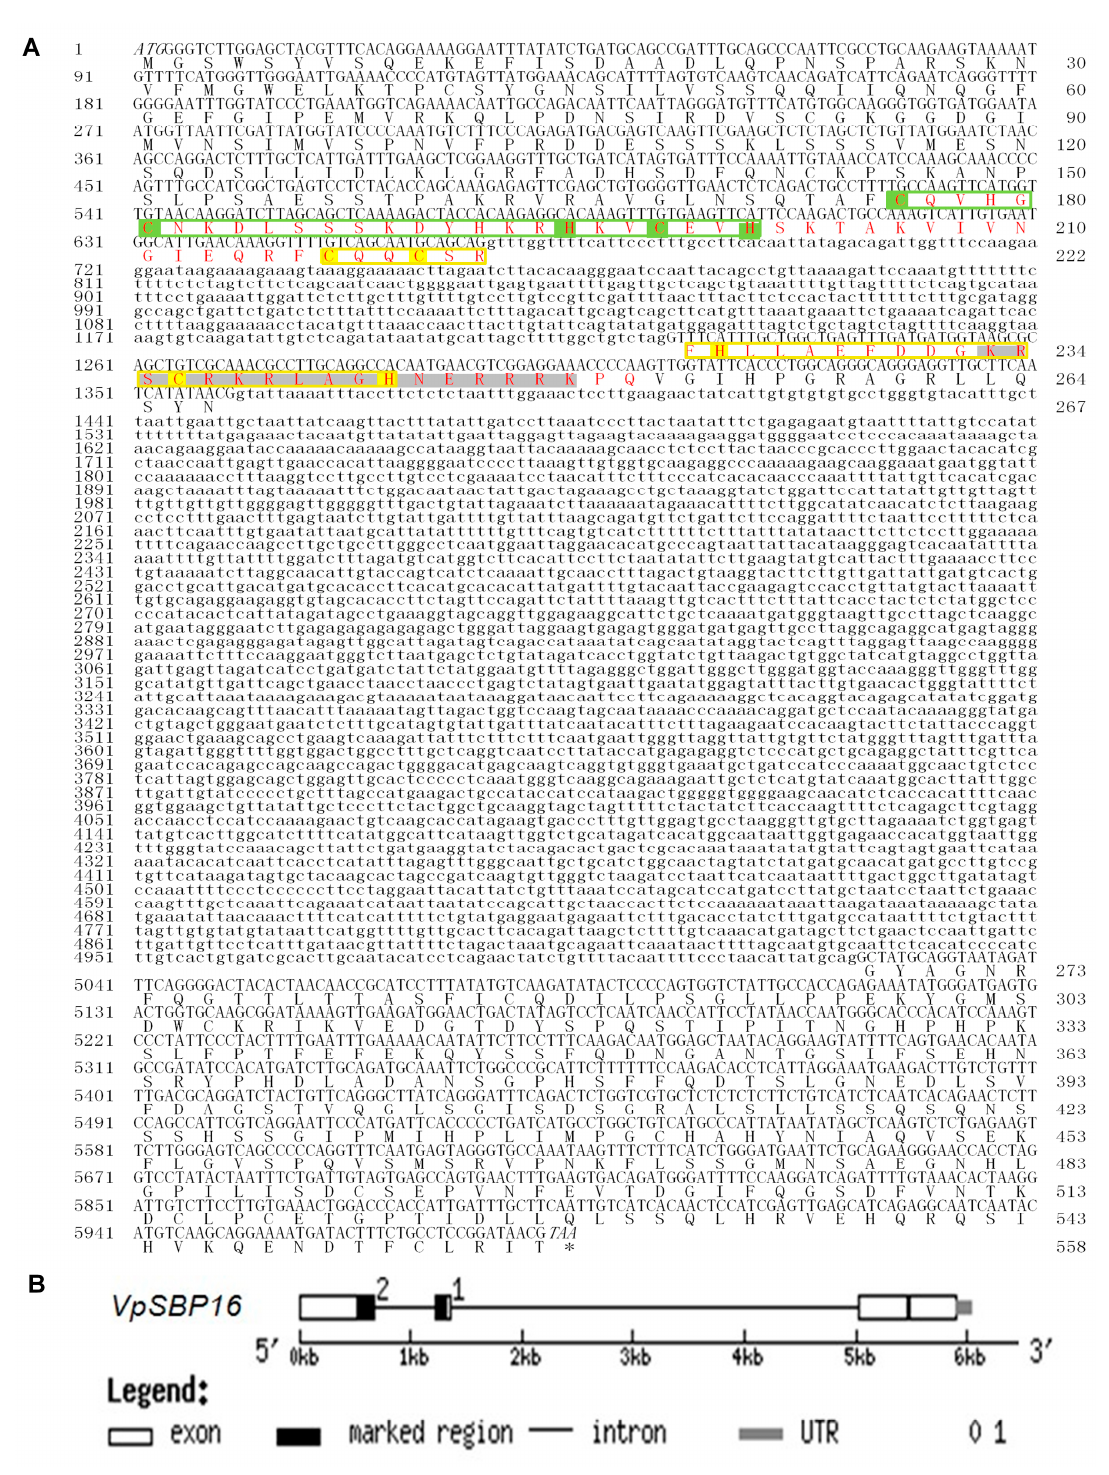
Figure 2. The DNA, cDNA nucleotide sequence and deduced amino acid sequence of VpSBP16 from V . pesudoreticulata ( A ) and Exon-intron structures of VpSBP16 ( B ). The SBP domain is shown in red and the two zinc-binding sites of the C2HCH type (zinc finger 1 and zinc finger 2) are indicated with green and yellow boxes. The conserved basic amino acids of the nuclear location signal are shaded in dark grey.